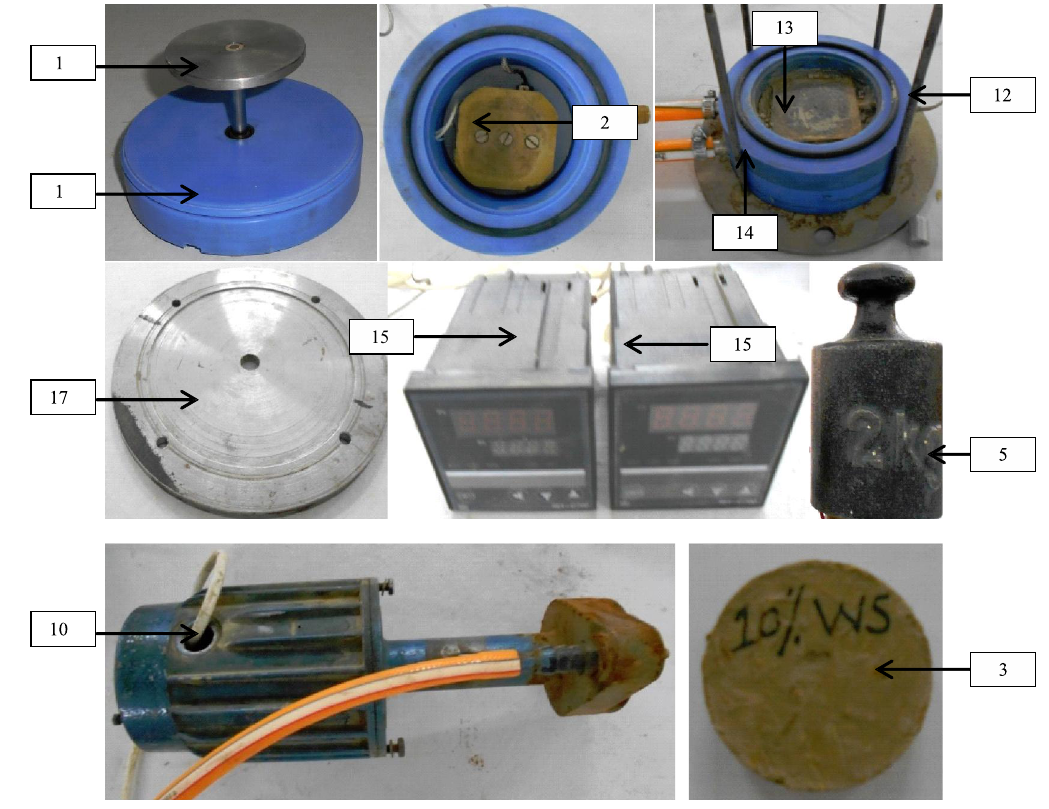
FIG. 3. COMPONENTS OF THE GUARDED HEAT FLOW THERMAL CONDUCTIVITY EXPERIMENTAL